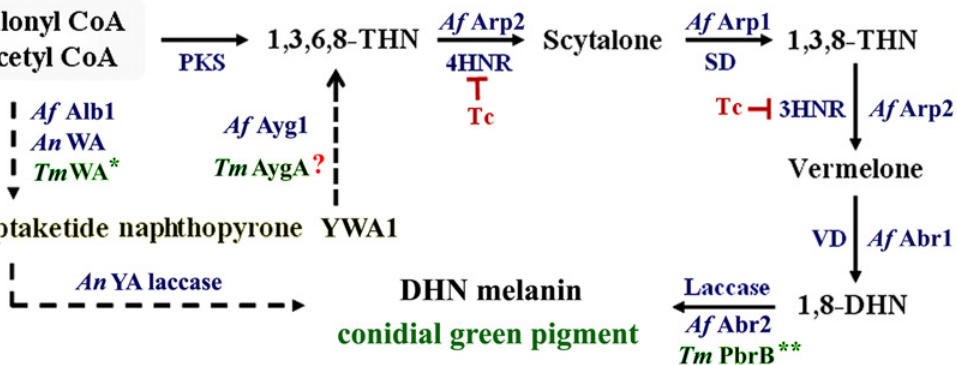
Fig 8. Predicted DHN melanin synthesis pathway in T . marneffei . A consensus biochemical pathway for DHN melanin synthesis based on what is known from other fungal systems is shown [15, 39, 50]. Processing steps of the well-known DHN pathway are presented with dark arrows. PKS, polyketide synthase; 4HNR, tetrahydroxynaphthalene reductase; SD, scytalone dehydratase; 3HNR, trihydroxynaphthalene reductase; VD, vermelone dehydratase; 1,3,6,8-THN, tetrahydroxynaphthalene; 1,3,8-THN, trihydroxynapthalene; 1,8-DHN, dihydroxynaphthalene. Tc, tricyclazole, can inhibit both reductases (4HNR and 3HNR) presented in a model pathway. Distinctive steps described in A . nidulans ( An ), A . fumigatus ( Af ), T . marneffei ( Tm ) are shown with dashed arrows. Asterisks, * and ** , refer to data from previous study [22] and this study, respectively.